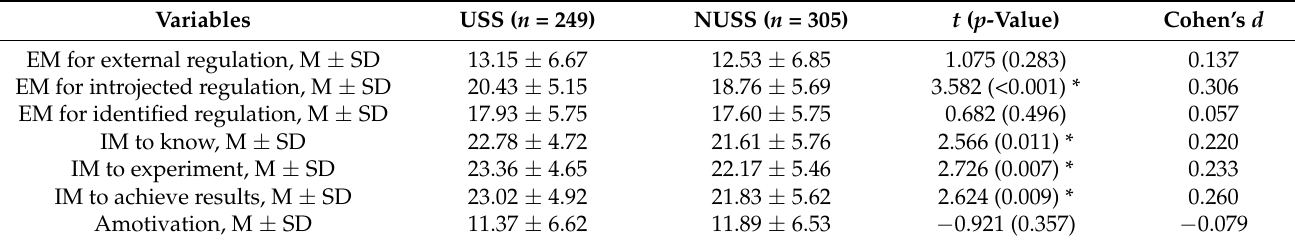
Table 3. Differences between USS and NUSS in sports motivation.